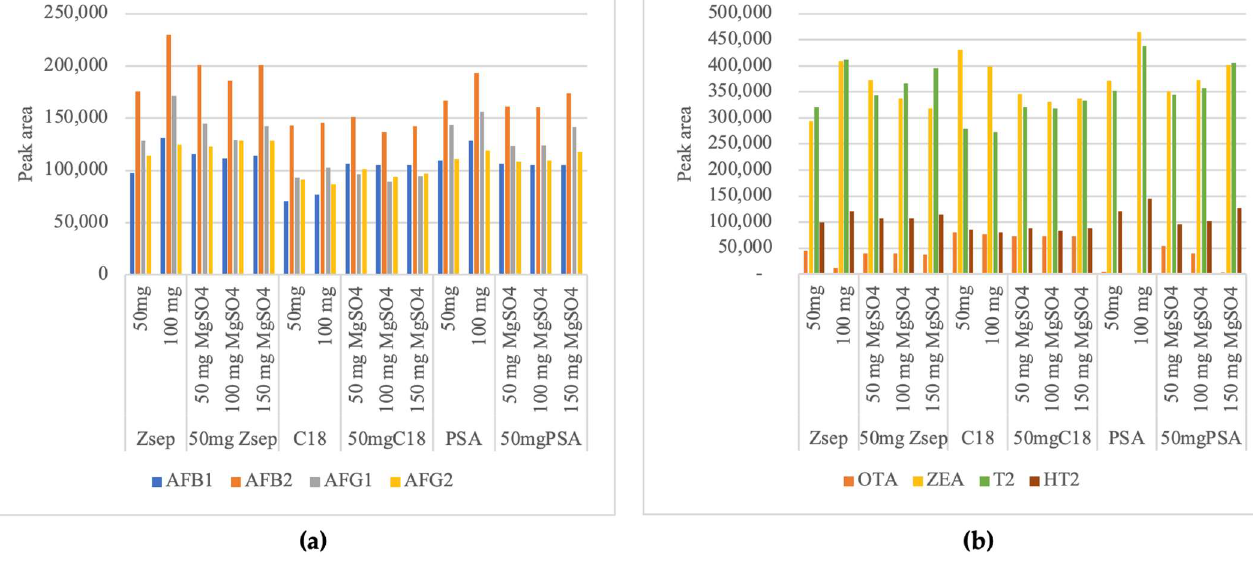
Figure 3. Average peak areas (n = 2) using silica gel with zirconium oxide (Z-Sep), octadecyl modified silica (C18), primary secondary amine (PSA), and magnesium sulfate (MgSO 4 ) sorbents in d-SPE clean-up of ( a ) AFs (AFB1–Aflatoxin B1; AFB2– Aflatoxin B2; AFG1–Aflatoxin G1; AFG2–Aflatoxin G2) and ( b ) Ochratoxin A (OTA), Zearalenone (ZEA), toxin T2 (T2) and toxin HT-2 (HT2).